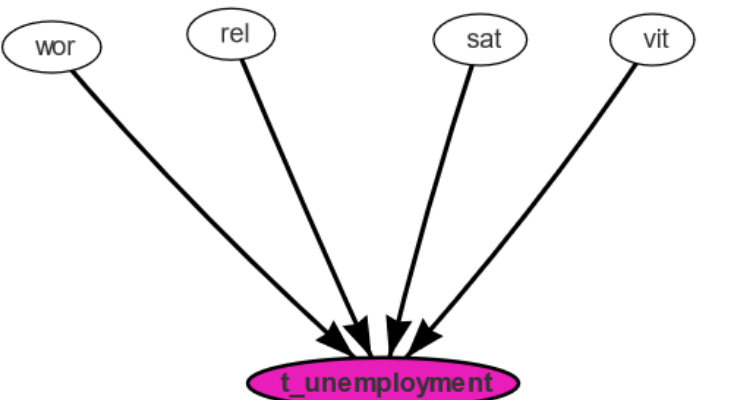
Figure 5. Social media data vs. official statistics: Bayesian network with the social network domains and the unemployment rate with a 90-day delay.